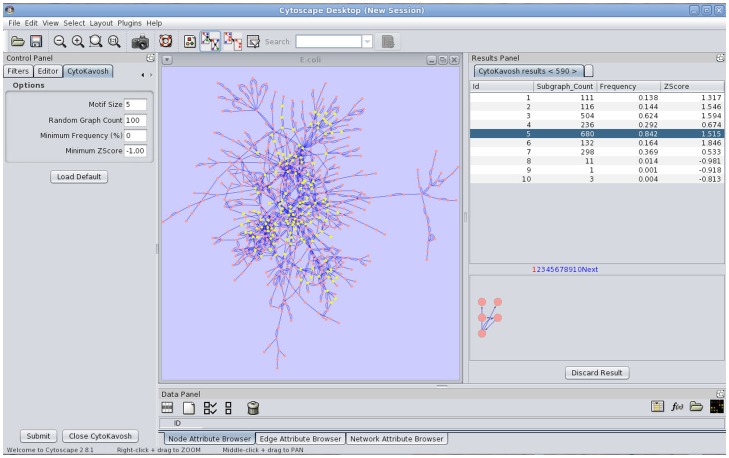
A sample of CytoKavosh ‘results’ table in which the motif size is 5 and the number of generated random networks is 100.All 590 motifs are listed in this picture in separate pages. Each page shows only 10 motifs. By clicking on each row (each motif), a graphical image of that motif appears in below panel. For exporting this view, we can right click on the row and export the motif in a separate network. For each running of CytoKavosh, there will open a new tab in ‘result’ panel, with the number shown in <> is the number of found motifs. In this sample, there are 590 motifs of size 5 for the transcriptional network of E. coli. Sub-graph count presents the number of sub-graphs of this motif type.